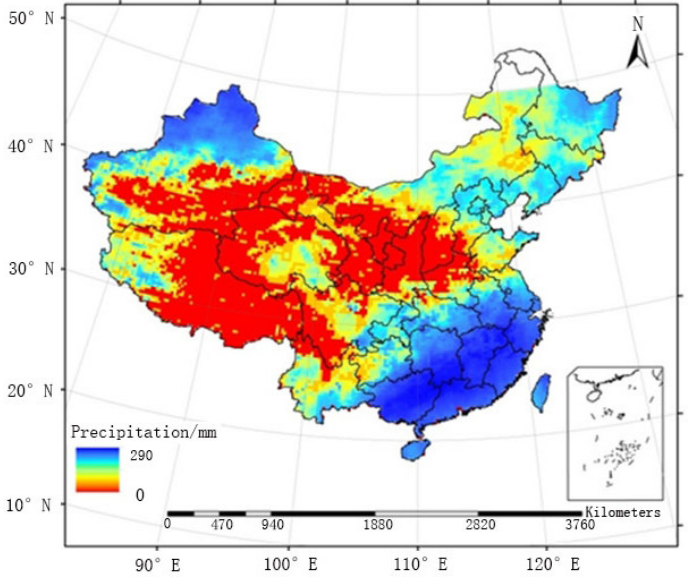
Figure 9. Raster map of the average monthly precipitation field generated by FMS between May and September from 2005 to 2010.